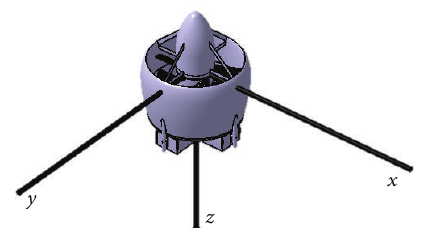
Figure 3: A coordinate system of the CNU ducted-fan UAV.